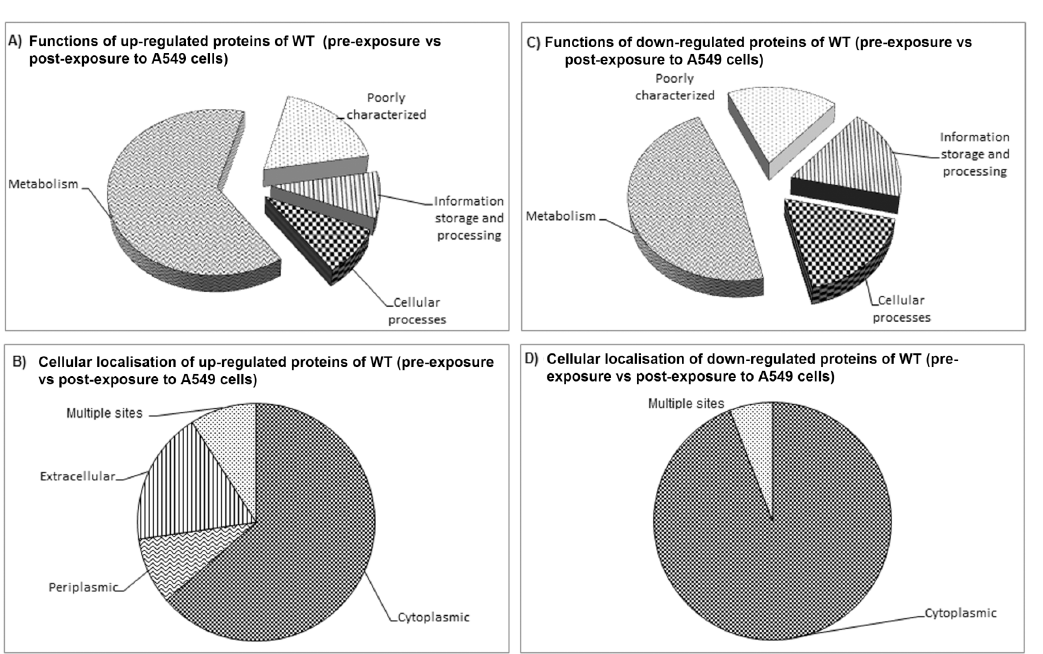
Fig 6. Protein categories and the subcellular localisation of Burkholderia pseudomallei WT (pre-exposure vs post-exposure to A549 cells). Functional protein categories were predicted using COG, while subcellular localisation was predicted using PSORT. Panels A and B refer to functions and cellular location of the up-regulated proteins, respectively. Panels C and D refer to functions and cellular location of the down-regulated proteins, respectively.